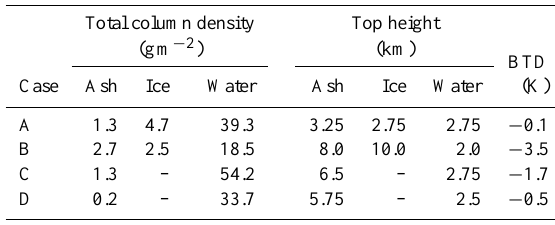
where ash is present and detected (C) and not detected (D). The liquid water cloud and ash cloud profiles are shown in the bottom left and right panels of Fig. 8. For location C the ash cloud is on top of a water cloud and thus readily visible in the simulated data. However, in the measurements the ash cloud is barely detectable. The cause of this discrepancy may be a wrong altitude of the simulated ash cloud or wrong ash load. Furthermore, the ice and water clouds may not be well represented in the model for this region. The MYSTIC and SEVIRI brightness temperatures are different in this region (see Fig. 4), indicating that the cloud structure is more com- plex than depicted by the ECMWF cloud fields. For location D the ash is above the water cloud and mixed with the water cloud. However, the larger part of the ash is contained above the water cloud. A slightly negative BTD is calculated from the simulations (Table 1). The value is, however, above the − 0.8 K cut-off limit. From the profiles and BTDs of loca- tions A and D it may be concluded that to obtain